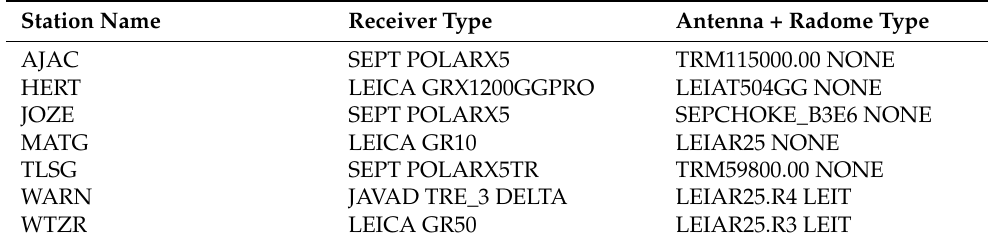
Table 3. The GNSS receivers and the antenna + radome types of the middle latitude